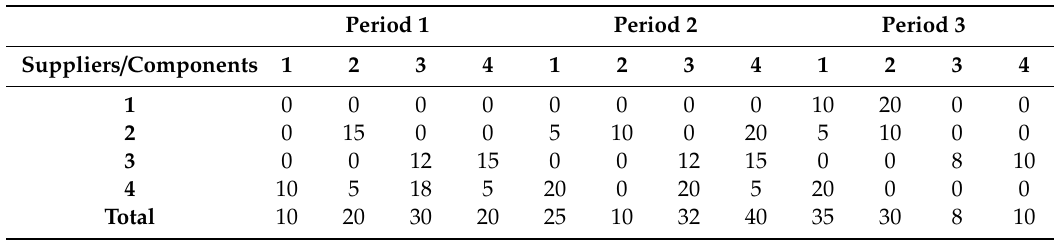
Table 8. Order quantity for components ( Q ijt